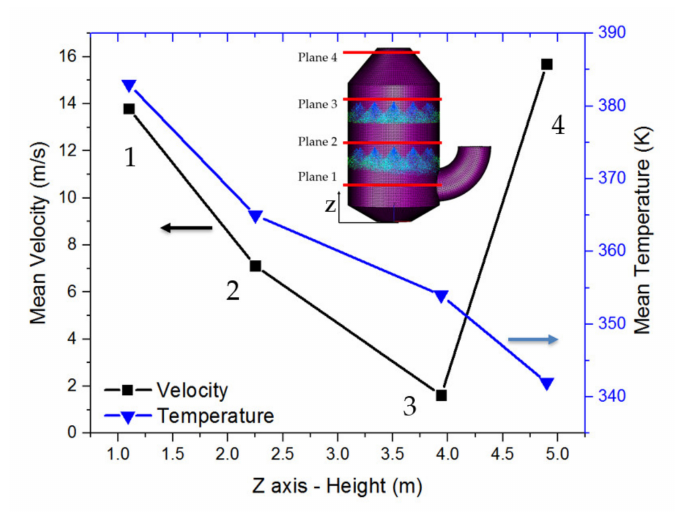
Figure 8. Velocity and temperature for the preferred planes along the flow direction.